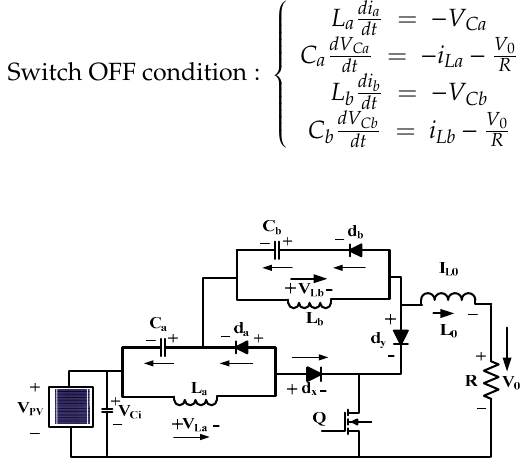
Figure 13. Stackable switching boost converter.